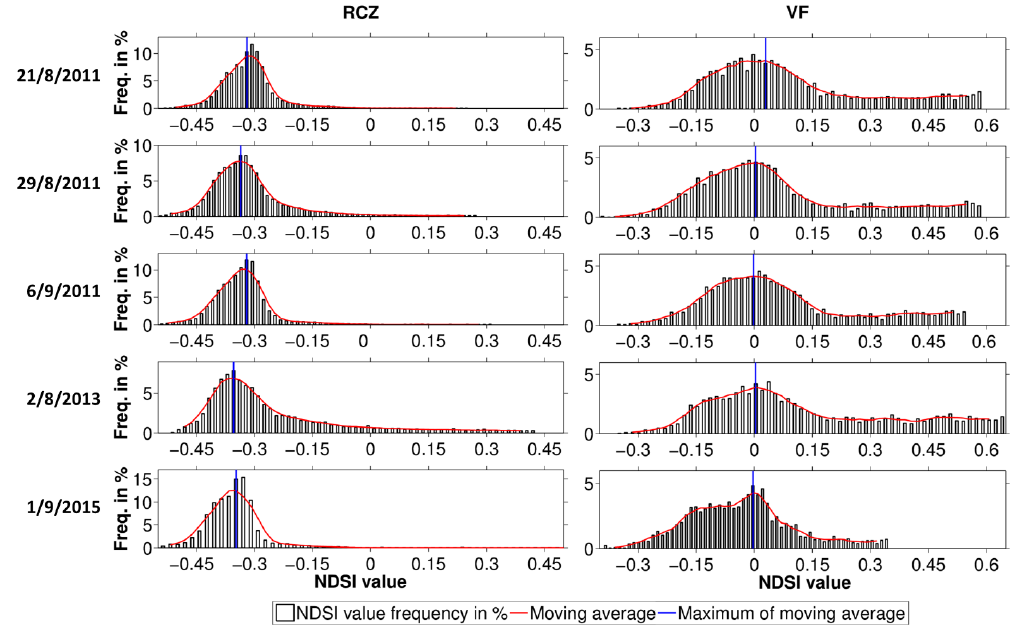
Figure 9. Representative NDSI values for the rock surfaces in RCZ and VF catchment are determined using frequency histograms of the snow-free bare rock NDSI values for five summer dates. A smoothed moving average of five histogram classes is shown with red. The maxima of the smoothed histograms are depicted in blue for each catchment and the dates